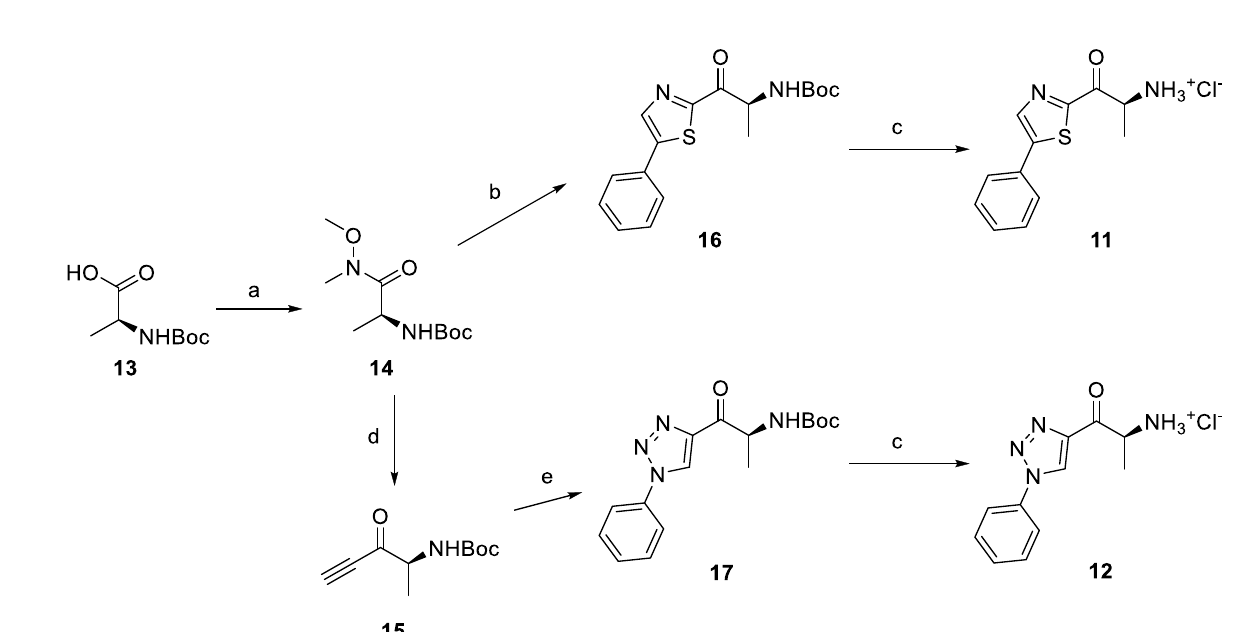
Figure 6. Scheme of the synthesis of alaninoyl triazole and thiazole derivatives. Reagents and conditions: (a) (i) carbonyldiimidazole (CDI), DCM, r.t., (ii) N , O -dimethylhydroxylamine hydrochloride, DCM, r.t.; (b) (i) 2-bromo-5-phenylthiazole, i -PrMgCl.LiCl, THF, -10 °C, (ii) 14 , i -PrMgCl.LiCl, -10 °C – r.t.; (c) AcCl, MeOH, r.t.; (d) (i) ethynylmagnesium bromide, THF, -78 °C, (ii) NaHSO 4 , H 2 O, 0 °C; and (e) phenyl azide, CuSO 4 .5H 2 O, sodium ascorbate, t- BuOH/H 2 O 1:1, r.t.